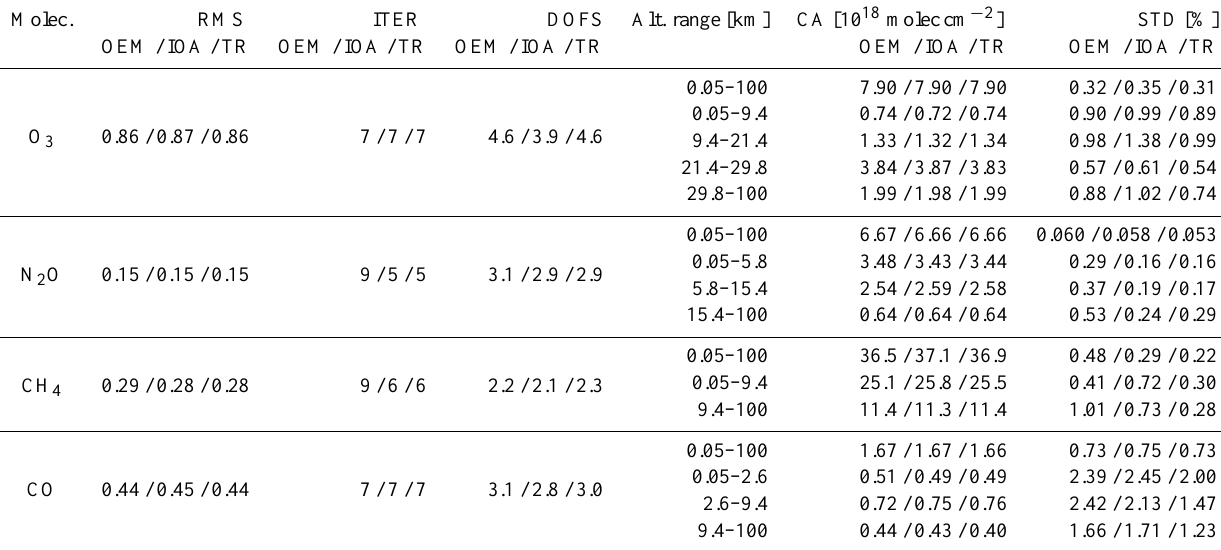
Table 4. Mean RMS of the fit residual, mean ITER, mean DOFS, total altitude range and common independent PC ranges, mean CA, and mean daily relative STD on the CA for the retrievals of O 3 , N 2 O, CH 4 and CO, from the 2007 campaign data at Ile de La R´eunion, when using the OEM, IOA and TR.